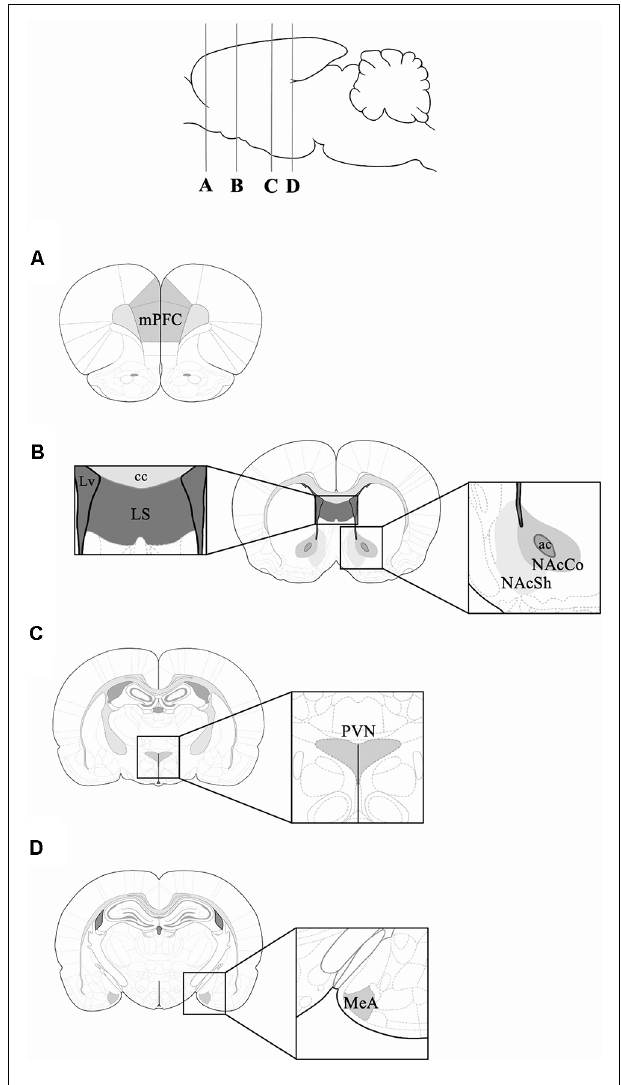
FIGURE 2 | Schematic representation of the coronal rat brain sections obtained for c-Fos immunohistochemistry. Coronal sections corresponding to: (A) mPFC (Bregma 3.72 mm); (B) lateral septum (LS), NAcSh and NAcCo (Bregma 1.20 mm); (C) PVN (Bregma − 1.92 mm); and (D) MeA (Bregma − 3.00 mm). mPFC, medial Prefrontal Cortex; MeA, Medial Amygdala; NAcSh, Nucleus Accumbens Shell; NAcCo, Nucleus Accumbens Core; PVN, Paraventricular Nucleus; Lv, lateral ventricle; cc, corpus callosum; ac, anterior commissure. Rat brain and coronal rat brain section illustrations were adapted from Paxinos and Watson